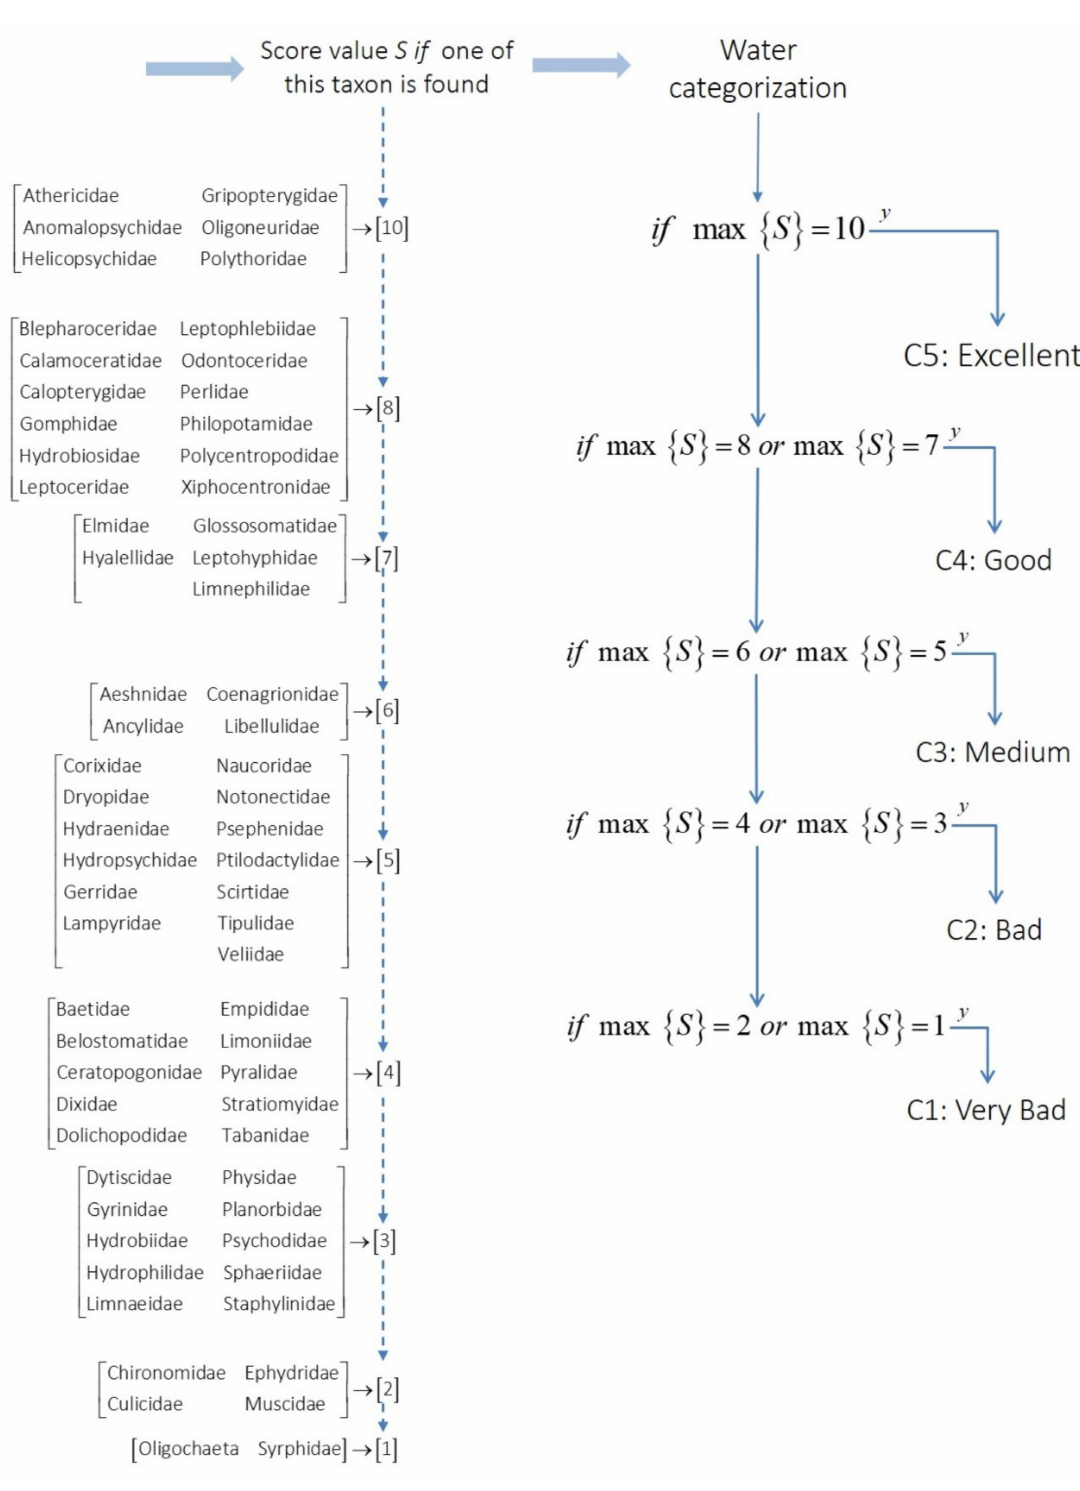
Figure 2. ABI* water quality